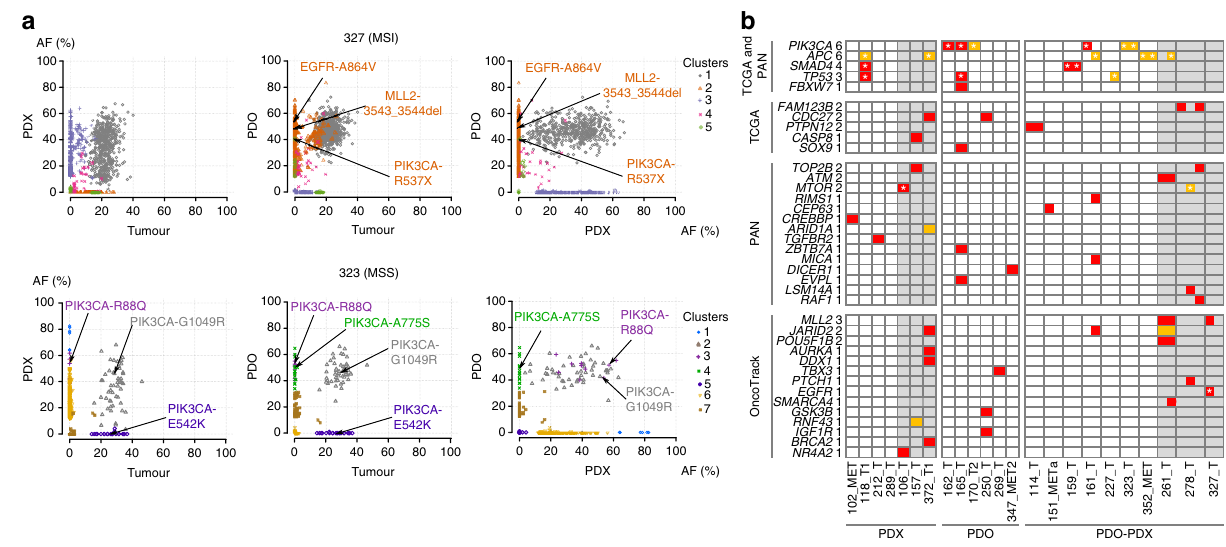
Figure 3 | Molecular discordances between original tumours and derived models in CRC-relevant genes. ( a ) Examples of clonality analysis based on the sciClone algorithm, for samples 327_T (MSI—40% tumour purity) (upper panel) and 323_T (MSS—60% tumour purity) (lower panel). The plots display the mutations in diploid regions clustered by their allele frequencies in: original tumour versus PDX (left), original tumour versus PDO (middle) and PDX versus PDO (right). Individual mutation clusters were shown by different colours where grey indicated the mutations found in common between the compared samples. The PDO derived from 327_Tdisplayed private EGFR , MLL2 and PIK3CA mutations in cluster 2. The PDX derived from 323_Tdisplayed different clones harbouring private mutations in PIK3CA . ( b ) Somatic clonal mutations discordant between patients/PDX (left), patients/PDO (middle) and patients/PDX/PDO (right). Genes found mutated only in either tumour or model (or in only one model) are marked by red squares. Genes with different mutations in tumours and models are marked by orange squares. Mutations validated by targeted sequencing are indicated with asterisk. MSI and hypermutated samples are shaded in grey: Only cancer-relevant genes are shown, selected from TCGA, PAN or OT recurrently mutated genes resources (see methods). Patients with a purity of Z 40% are